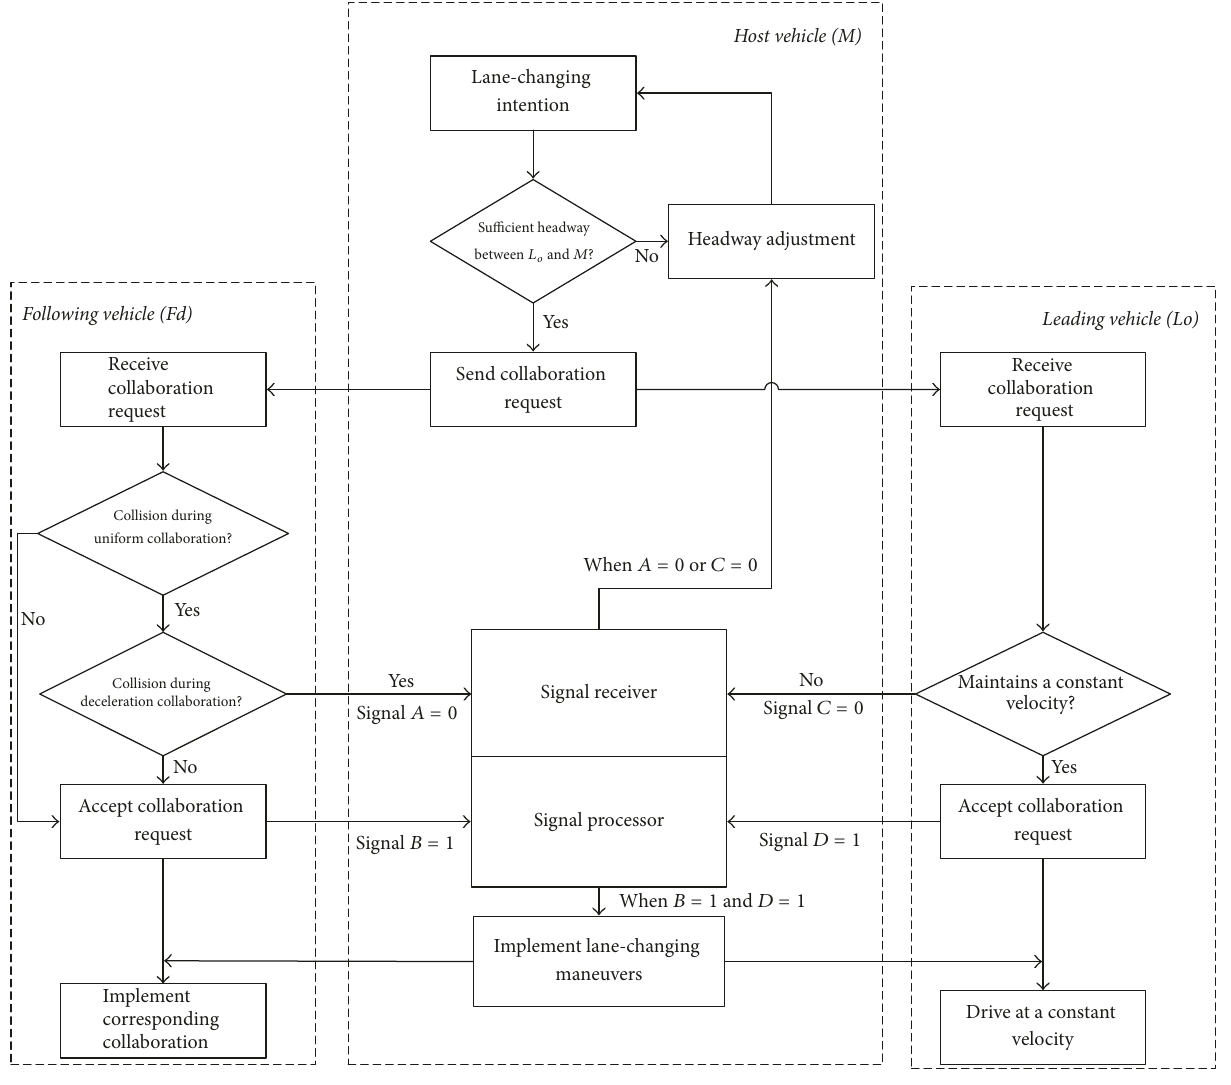
Figure 2: Schematic of the V2VC